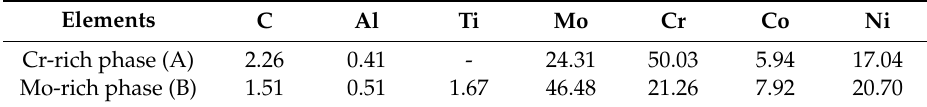
Table 3. Chemical compositions measured by EDX in SEM: the Cr-rich phase (EDX A in Figure 4g) and Mo-rich phase (EDX B in Figure 4g) (wt %).